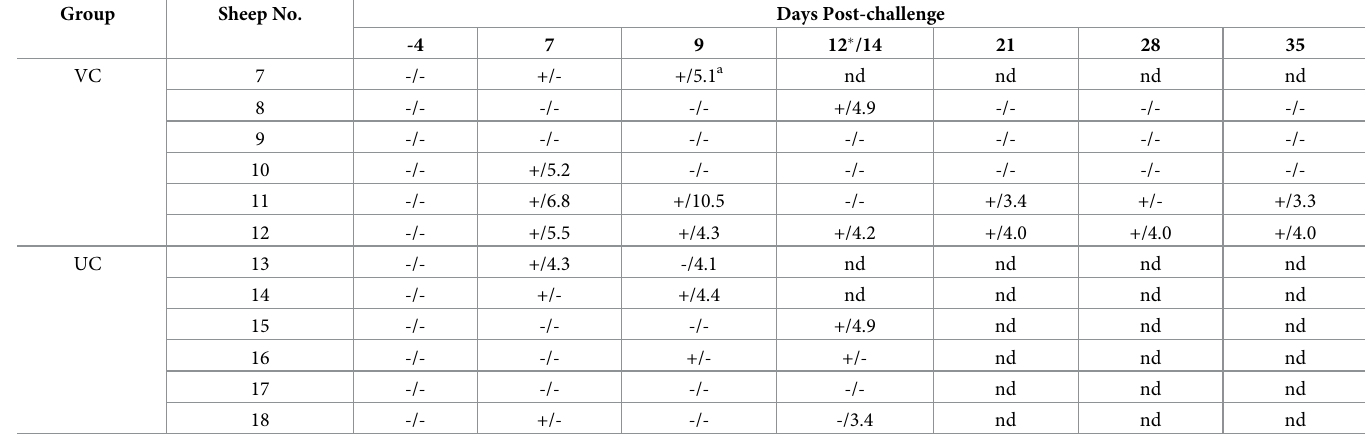
Table 2. Detection of FMDV in probang samples from vaccinated in-contact transmission sheep (VC) and unvaccinated in-contact transmission sheep (UC). Reported as detection by VI/RT-qPCR. Group Sheep